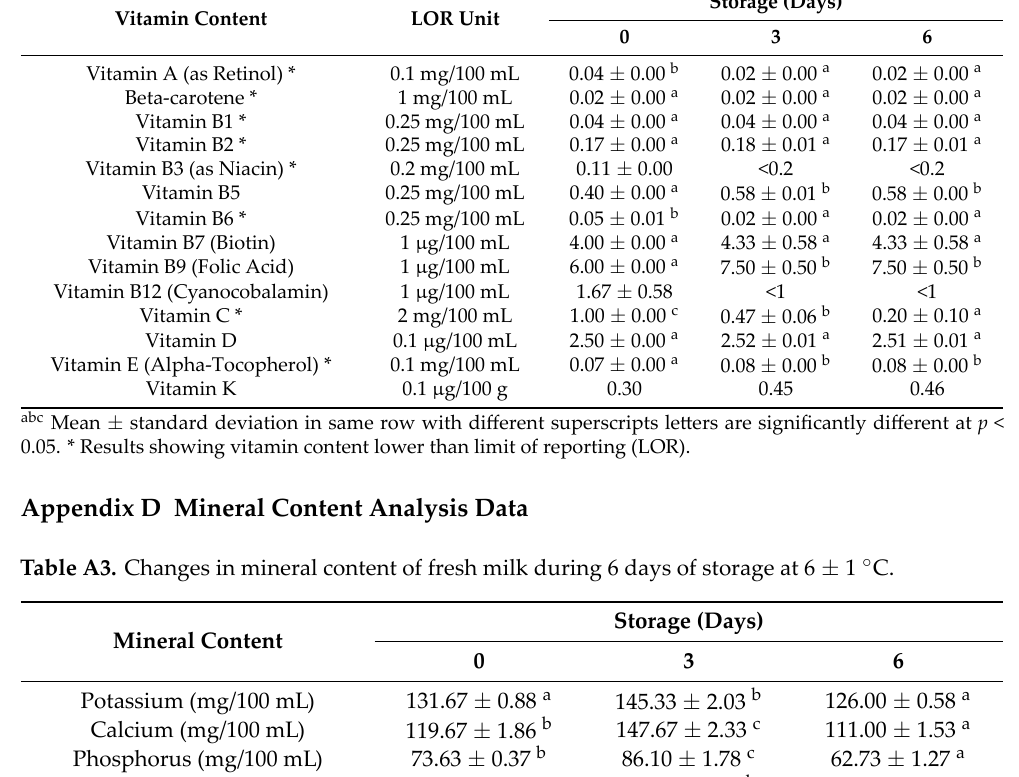
Table A2. Changes in vitamin content of fresh milk during 6 days of storage at 6 ± 1